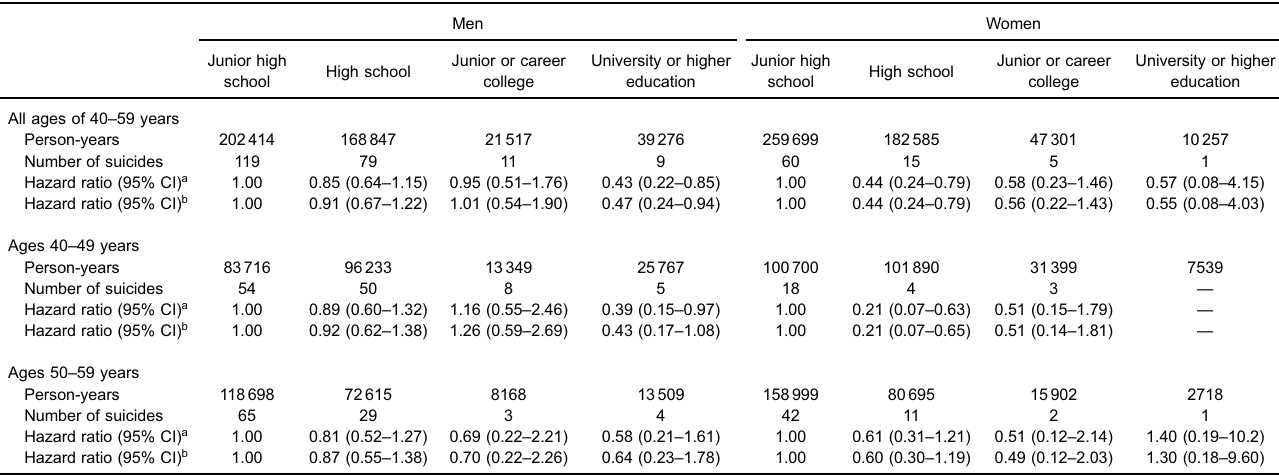
Table 2. Sex-speci fi c hazard ratios of suicide according to educational levels